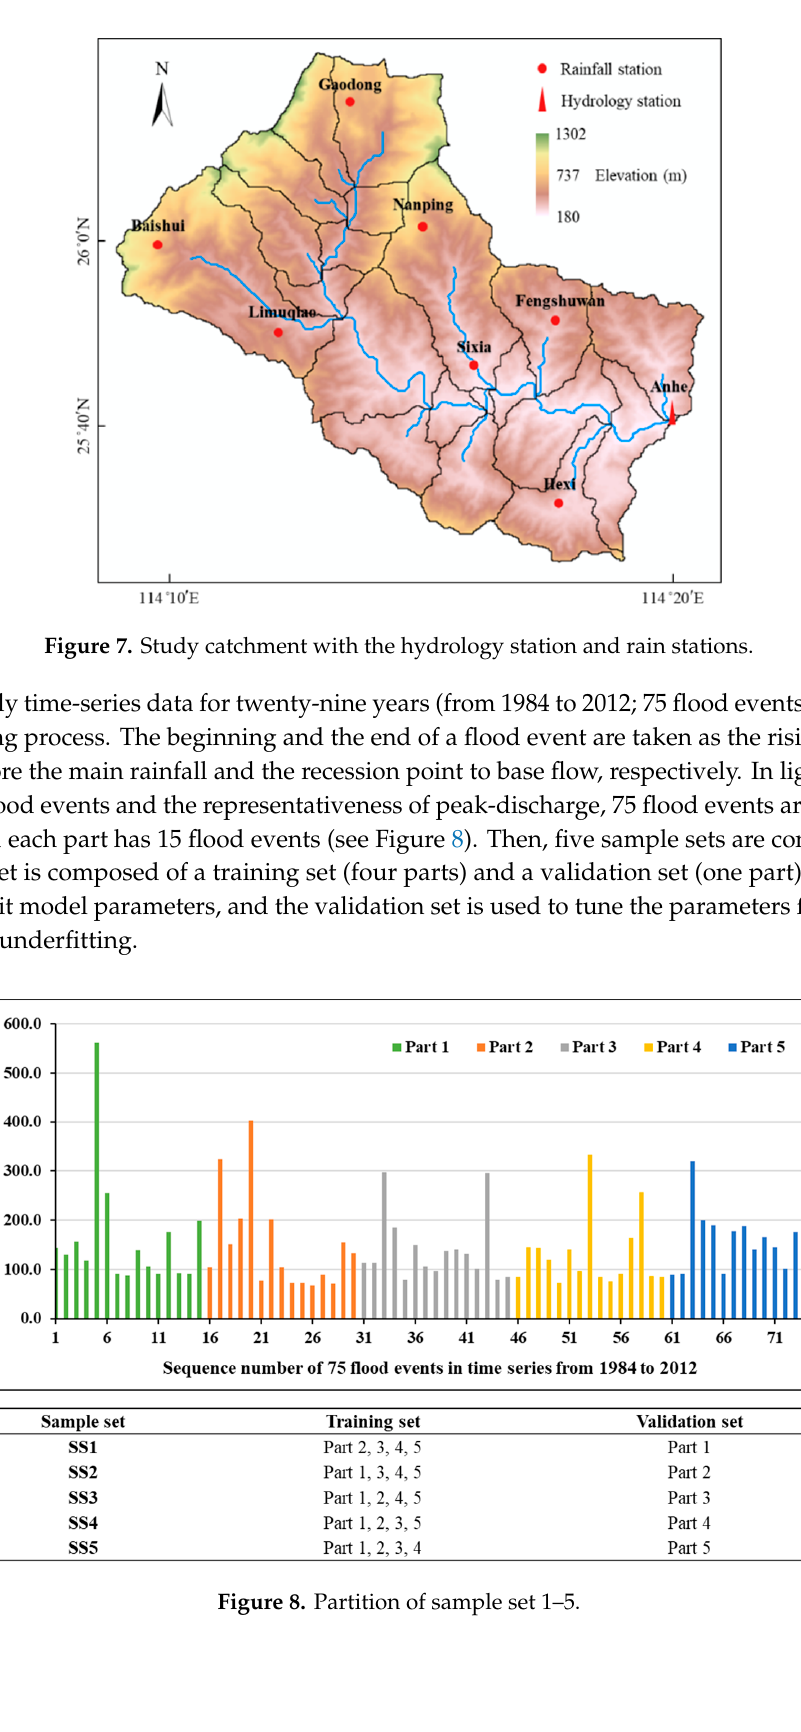
Figure 8. Partition of sample set 1–5.